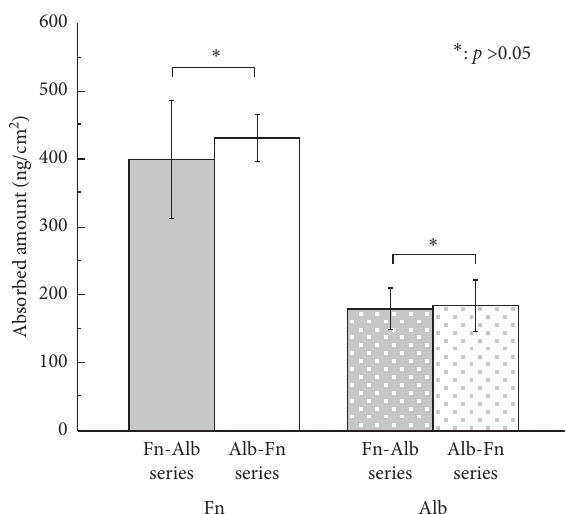
Figure 6: Adsorbed amounts of Fn and Alb on ZrO different two-step adsorption methods. Table 2: k obs values for adsorption of Fn and Alb on ZrO 2 sensor obtained 5 minutes after injection.